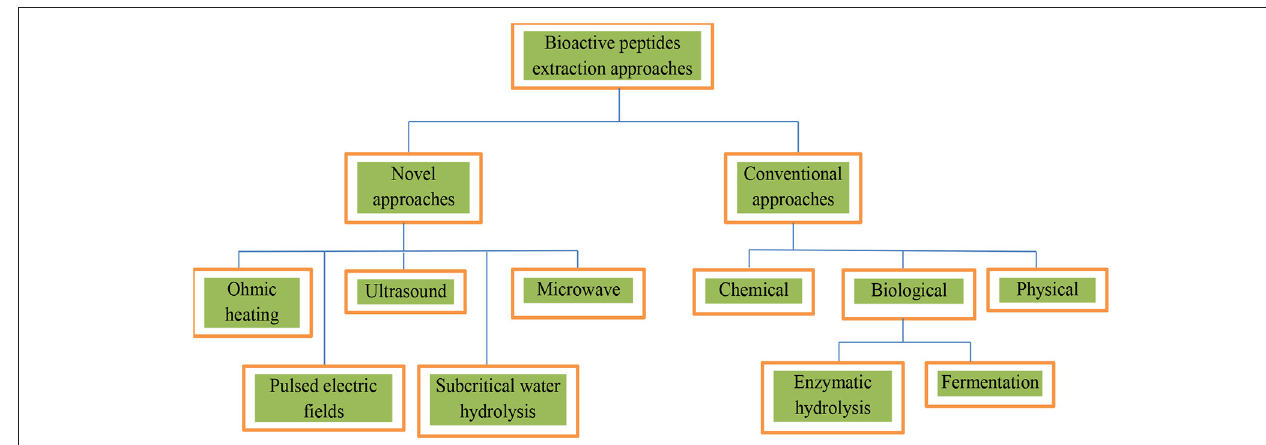
FIGURE 1 | Scheme for extracting bioactive